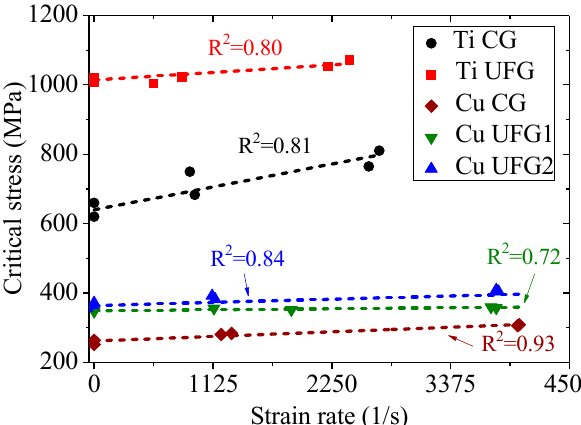
Figure 4. Comparison of the critical stress (yield strength 0.2%) dependencies on a strain rate in a compression test of cylindrical specimens of titanium and copper with coarse-grained (CG) and ultrafine-grained (UFG) structures. Structures UFG1 and UFG2 were obtained with 4 and 8 passages of equal-channel angular pressing (ECAP) [30]. R 2 is the coefficients of determination.